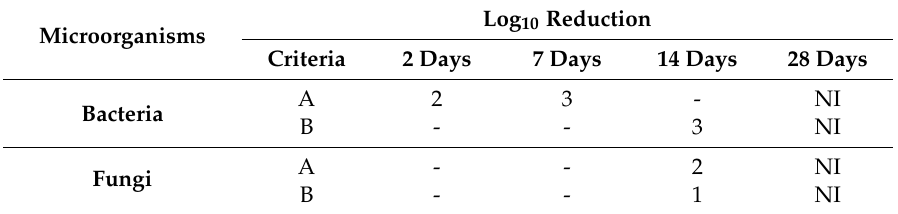
Table 3. Criteria for evaluation of antimicrobial activity for preparations for cutaneous application according to Ph. Eur.